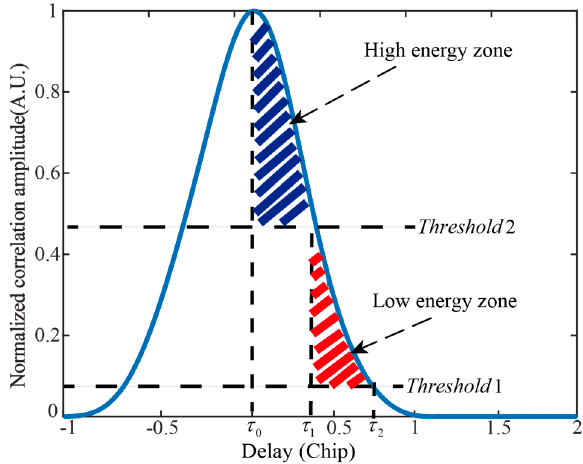
Figure 2. Definition of the low energy zone and the high energy zone from the normalized delay waveform.